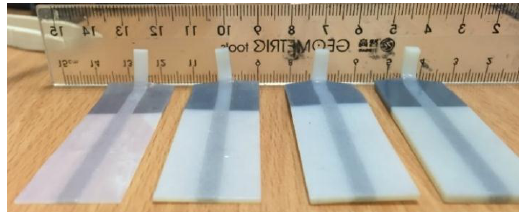
Figure 34. Folding line 2.